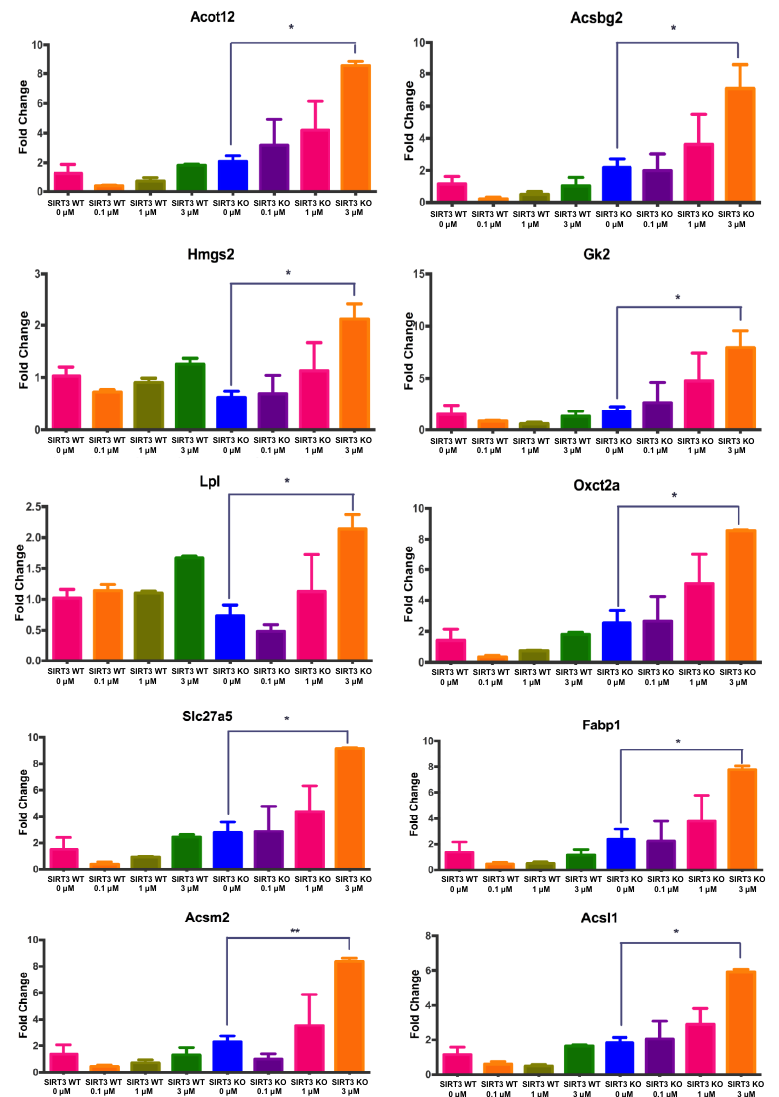
Figure 6. 4OH-PCB11 caused increased expression of genes associated with fatty acid oxidation in SIRT3-KO MEFs. WT and SIRT3-KO MEFs were trypsinized and plated. After 24 h, cells were treated in triplicate with 0.1, 1, and 3 μM of 4OH-PCB11 for an additional 24 h. To quantitate mRNA expression for fatty acid metabolism, total RNA was extracted with a QIAGEN RNA Extraction kit. Total RNA was reverse transcribed, and qRT-PCR was performed. The CT values for the target genes were normalized to the 18S rRNA transcript, the fold difference (relative abundance) was calculated using the formula 2- ∆∆ CT, and the mean was plotted. N = 3; * p < 0.05; ** p <